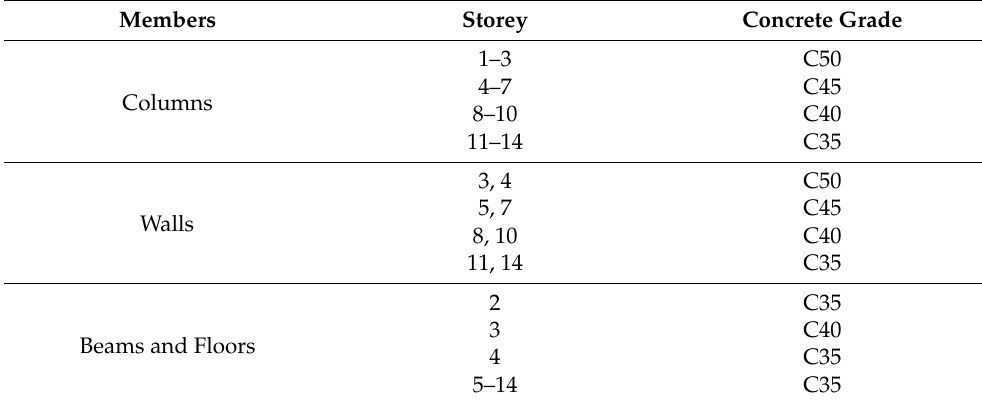
Table 2. Concrete grades of different structural members in different